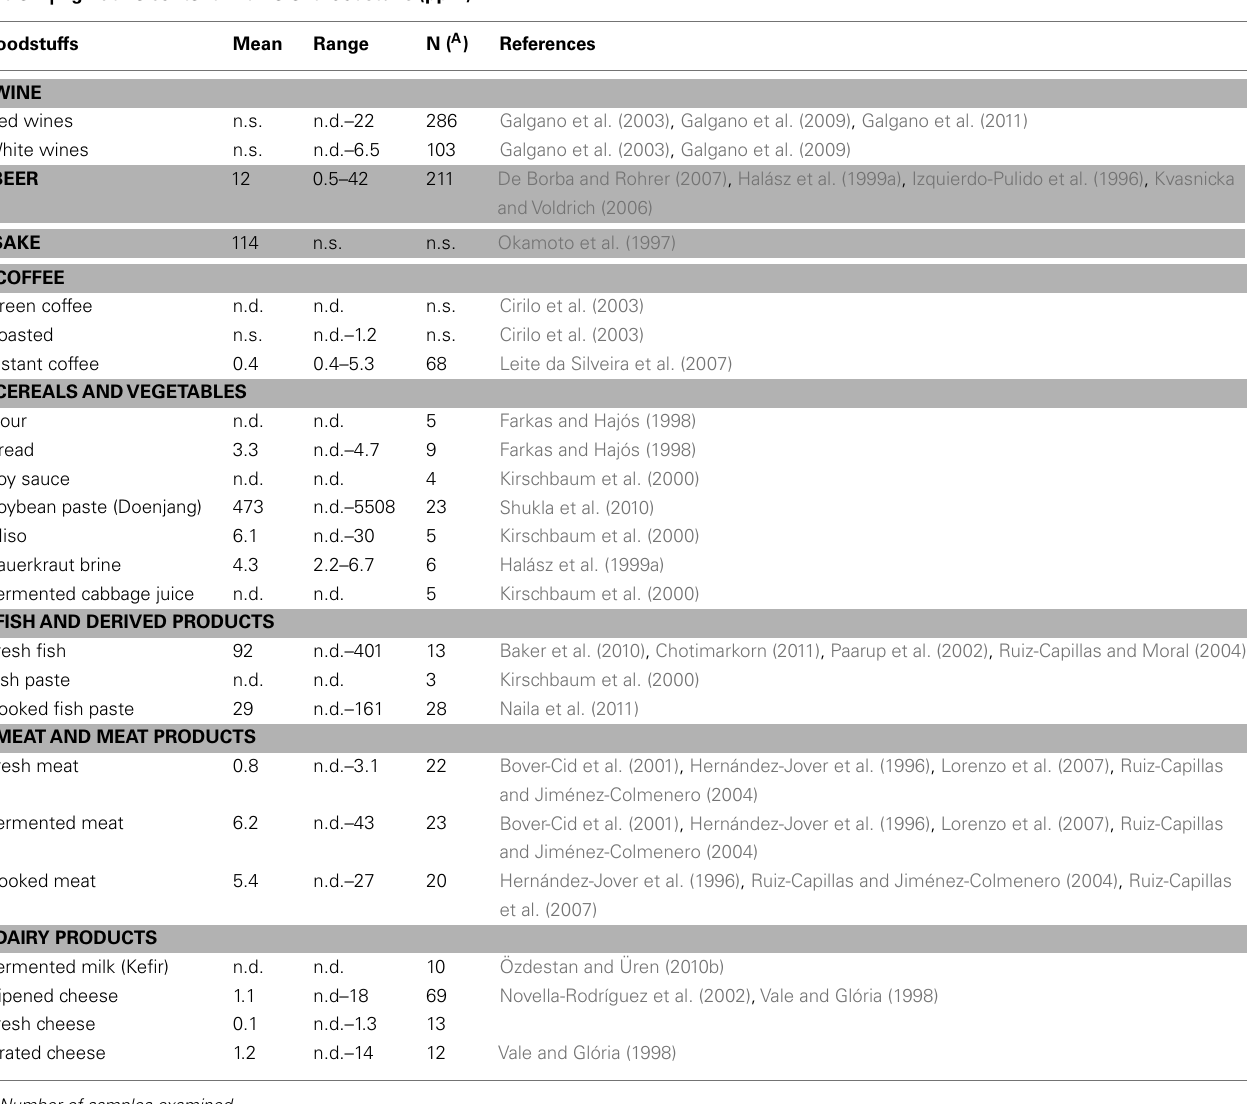
Table 1 |Agmatine content in different foodstuffs